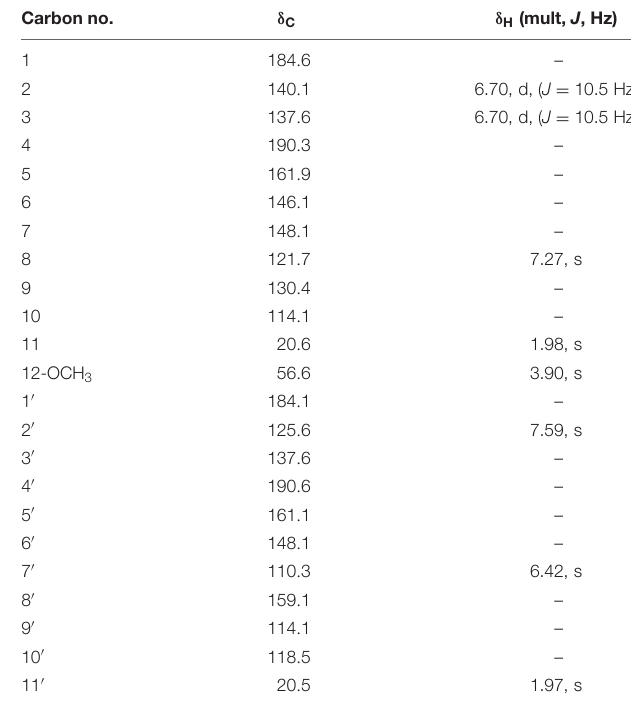
TABLE 2 | 13 C-NMR and 1 H-NMR spectral data of compound